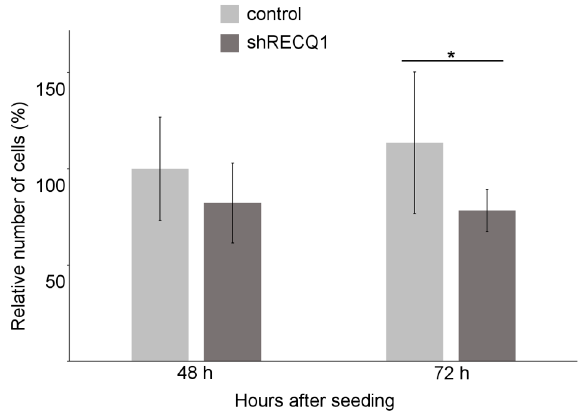
Figure 2. Differences in the rate of increase in cell number between RECQ1-silenced and control U87 DsRed cells as determined by direct counting at 2 days and 3 days after seeding. Significant differences (* = p ≤ 0.05) in cell number were found at 72 h after seeding.